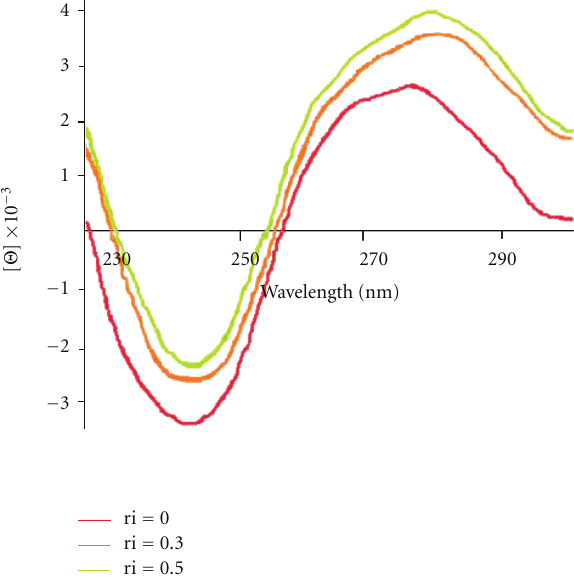
Figure 3: Circular dichroism spectra of CT-DNA (5 × 10 − 5 M) in the presence of increasing amounts of Pt(II) complex at the follow- ing stoichiometric ratios (ri = [complex]/[DNA] = 0.0, 0.4, 0.5).